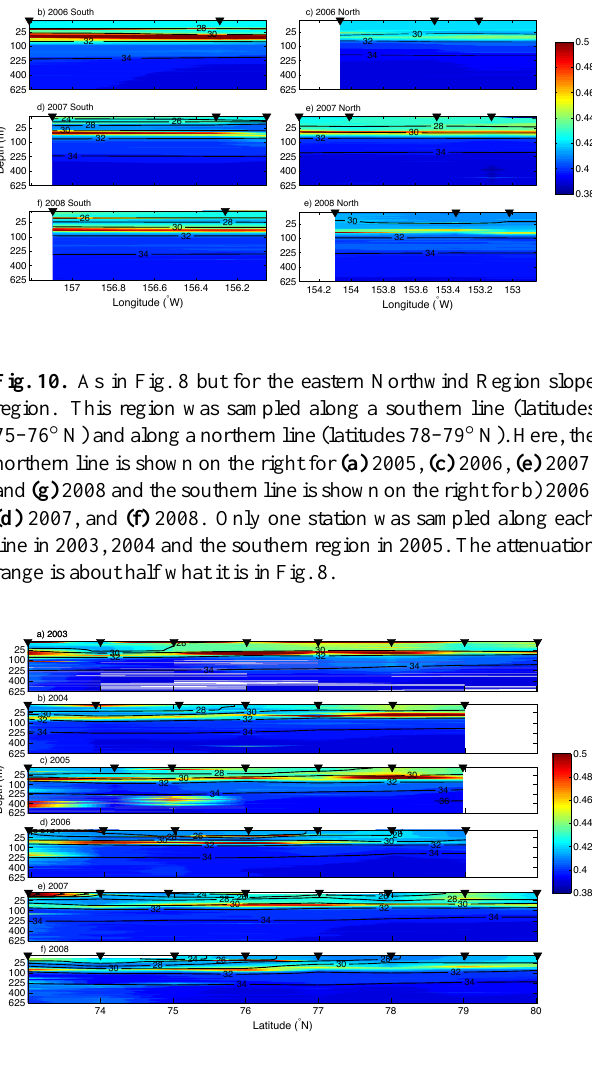
Fig. 11. As in Fig. 8 but for the interior of the Canada Basin for the years (a) 2003, (b) 2004, (c) 2005, (d) 2006, (e) 2007, and (f) 2008. These stations were located along the 150 ◦ W section, which is a continuation of the western Beaufort shelf section. Note that the attenuation range is about half what it was in Fig.